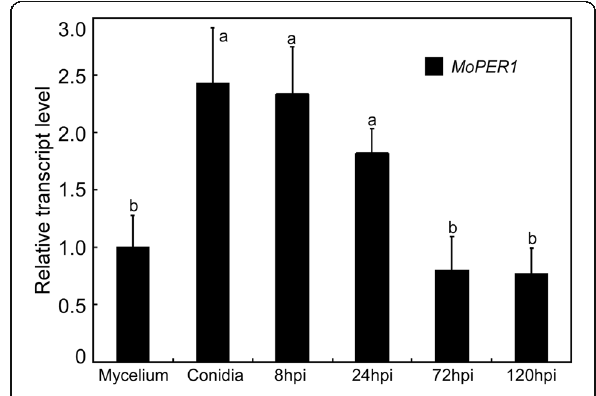
Fig. 1 transcription profiles of MoPER1 at different stages of fungal development. The phase-specific expression of MoPER1 was quantified by quantitative real-time polymerase chain reaction (qRT- PCR), with the synthesis of cDNA from each sample including infectious growth, vegetative growth and conidia. Hpi: hour post